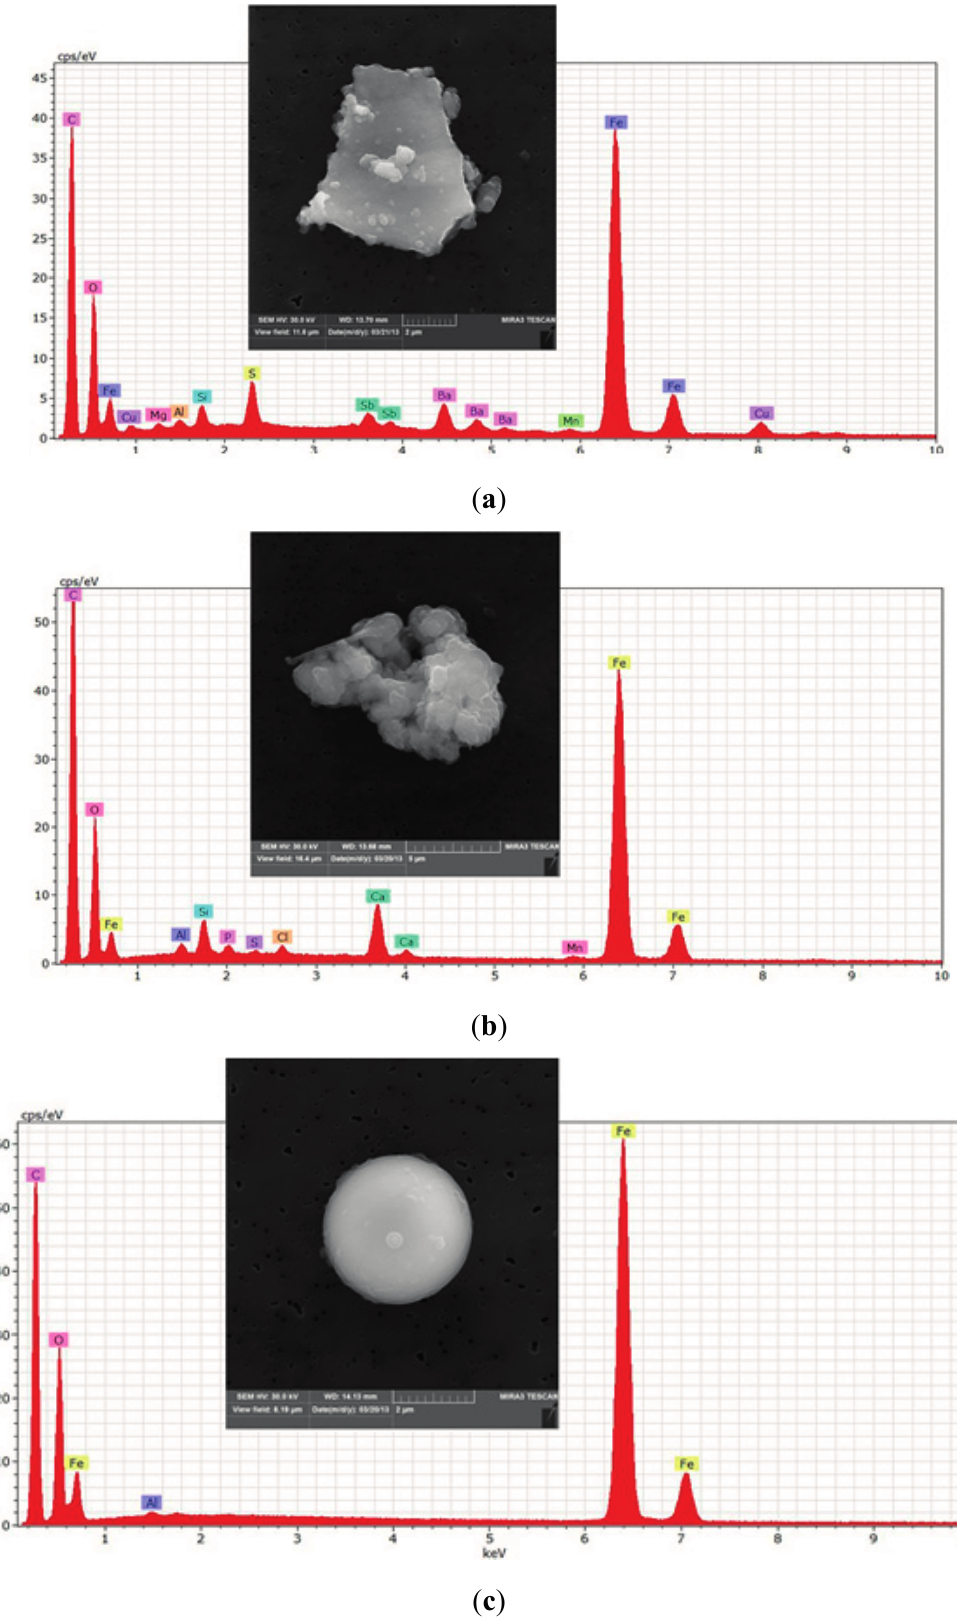
Figure 4. ( a ) Likely automotive brake wear particle from Dobong with Ba, S, Sb, and Cu. ( b ) Fe-Ca-Si particle from Dobong, similar to those found in subway. ( c ) Iron-oxide sphere from Guro, typically associated with steel